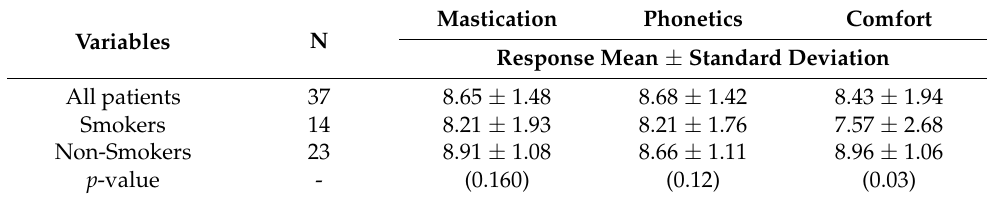
Table 2. Satisfaction among patients on a VAS out of 10.